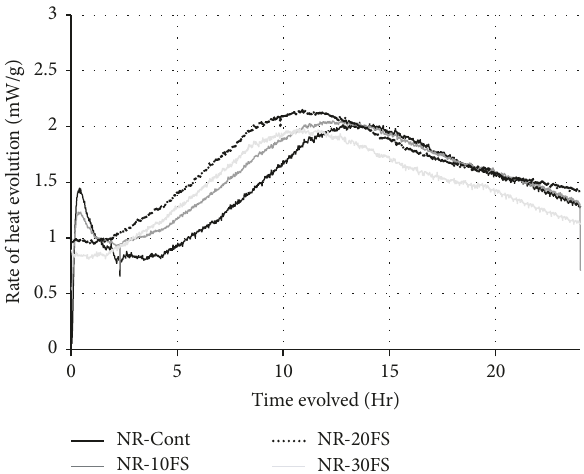
Figure 7: Heat flow curves for UHSC-FS mixtures using reactive